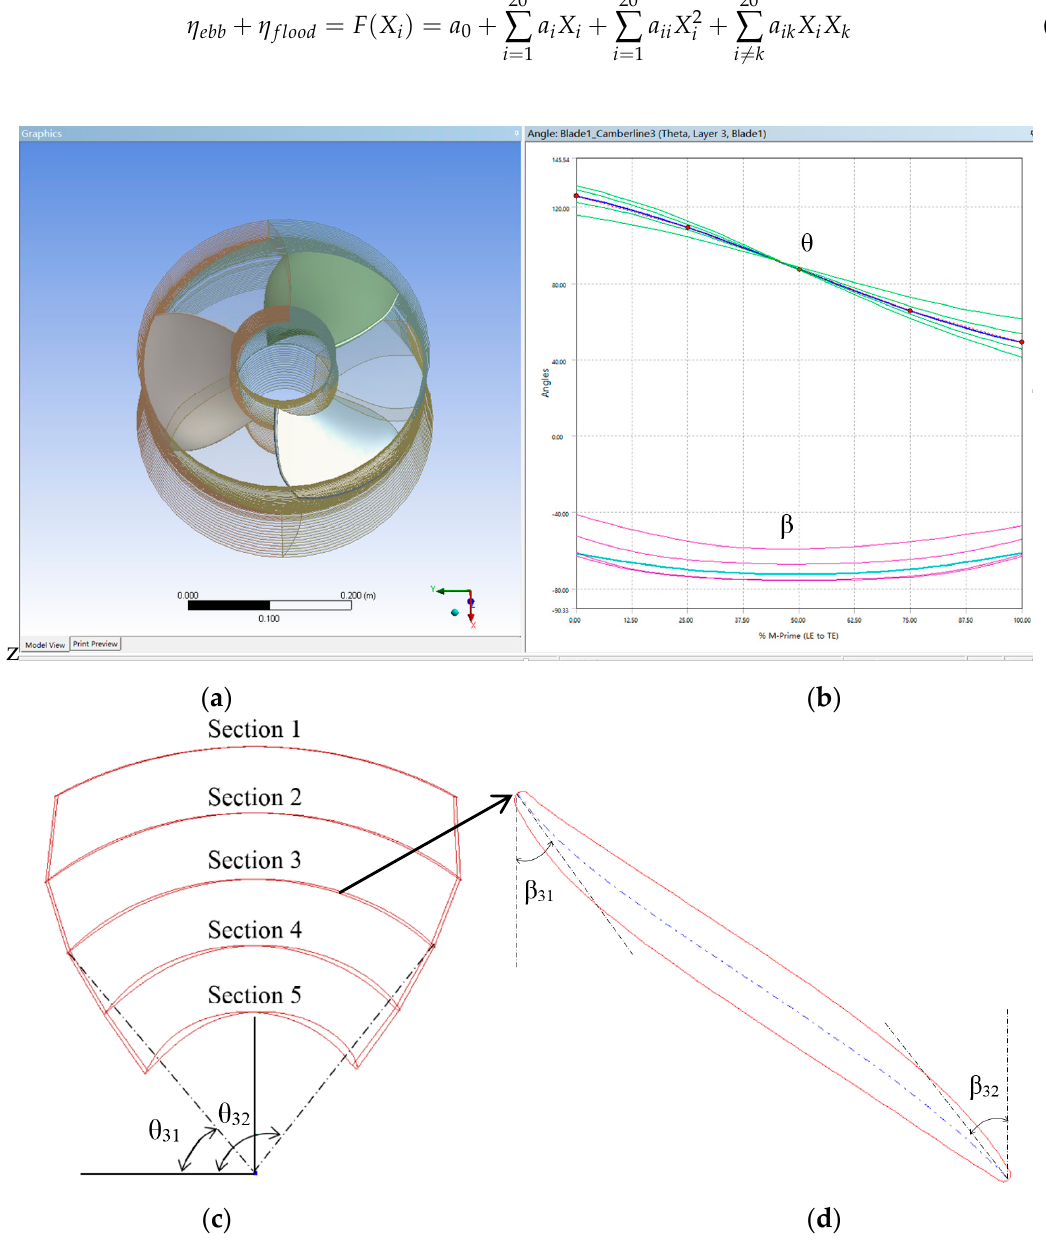
Figure 3. Parametric representation of the blade. ( a ) 3D blade; ( b ) θ and β values in each section; ( c ) Definition of θ ; ( d ) Definition of β .